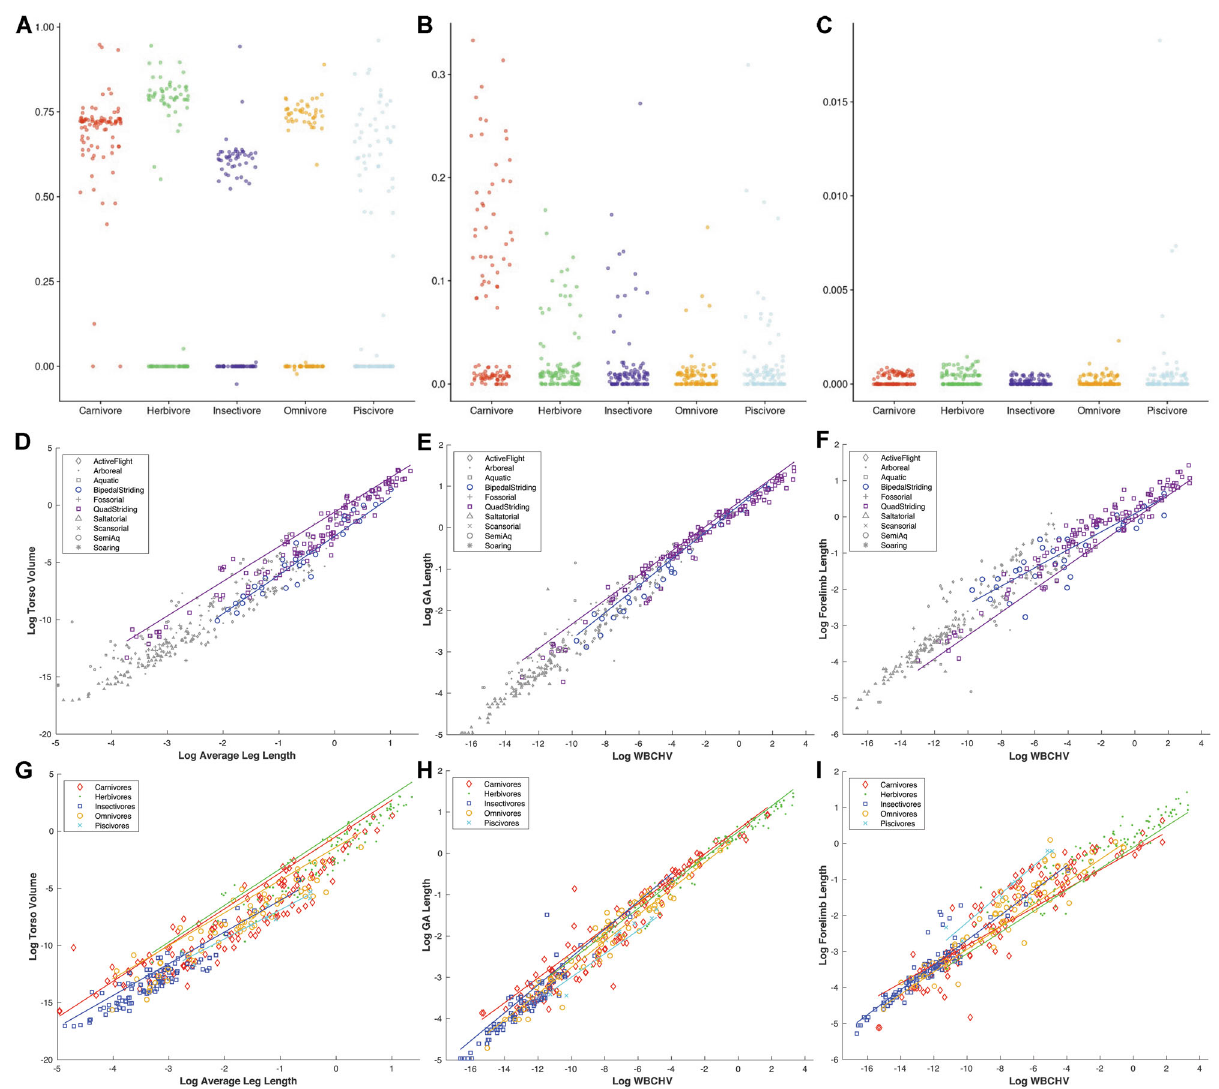
Fig. 6 | Evolution and scaling of torso and forelimb lengths in tetrapods. Relative torso and forelimb size in quadrupedal striding and herbivorous taxa (Hypothesis 6). Results for the OUwie analysis for normalised torso volume in dietary categories, showing estimates of A macroevolutionary optimum ( θ ), B selection strength ( ɑ ) and C evolutionary rate (Hypothesis 3). In all three panels, each point corresponds to the parameter estimate for one of the sampled simu- lated evolutionary regimes. For all trophic regimes across tetrapods generally, the best fi tting models for the torso were OU models, indicating some selection towards different torso volumes for taxa with different trophic